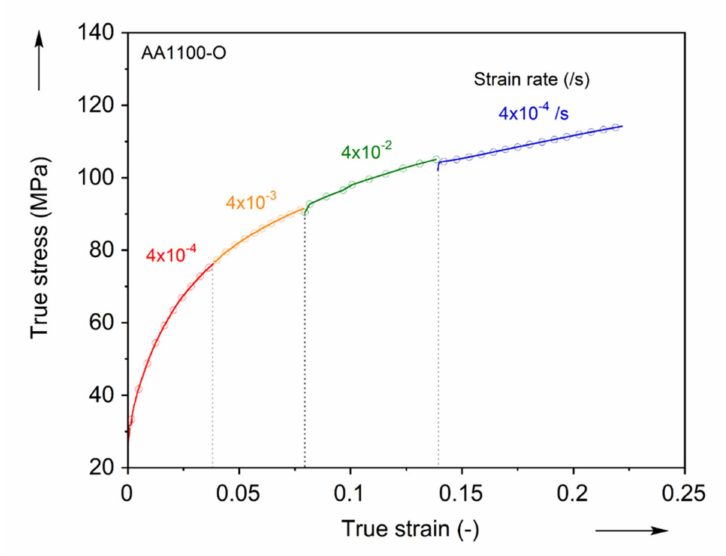
Figure 8. Jump test to measure the strain-rate dependence of